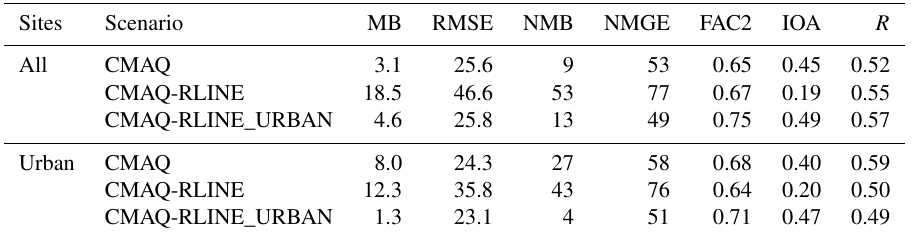
Table 2. Model performances under different